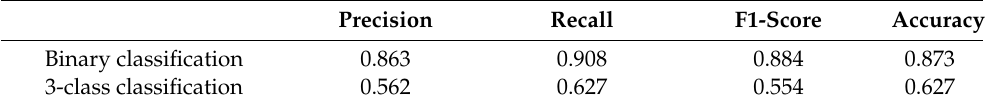
Table 8. Performance result comparison for binary and 3-class classification.